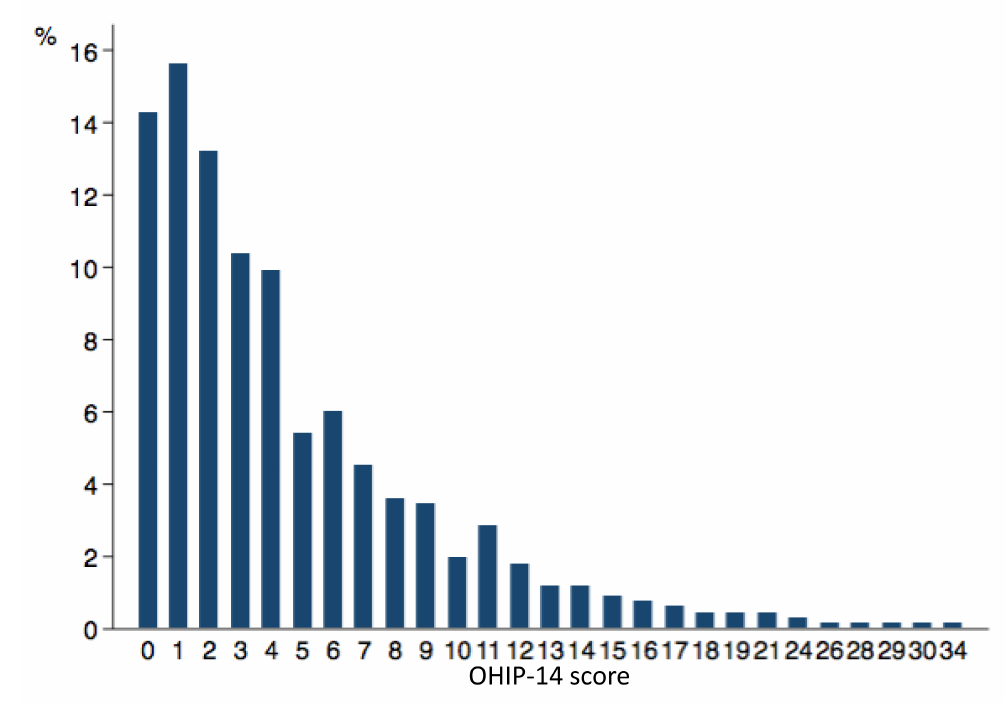
Figure 1. Histogram of the Oral Health Impact Profile 14 (OHIP-14) score in the overall study sample ( n =